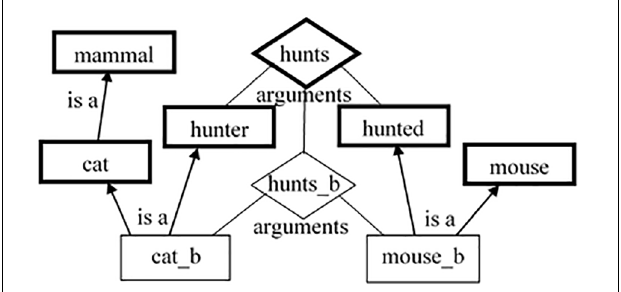
FIGURE 2 | Schematic description of part of the RoleMap ’s knowledge. The diamond shapes point to relations; the bold rectangles – to concepts; the thin rectangles – to instances (All links are